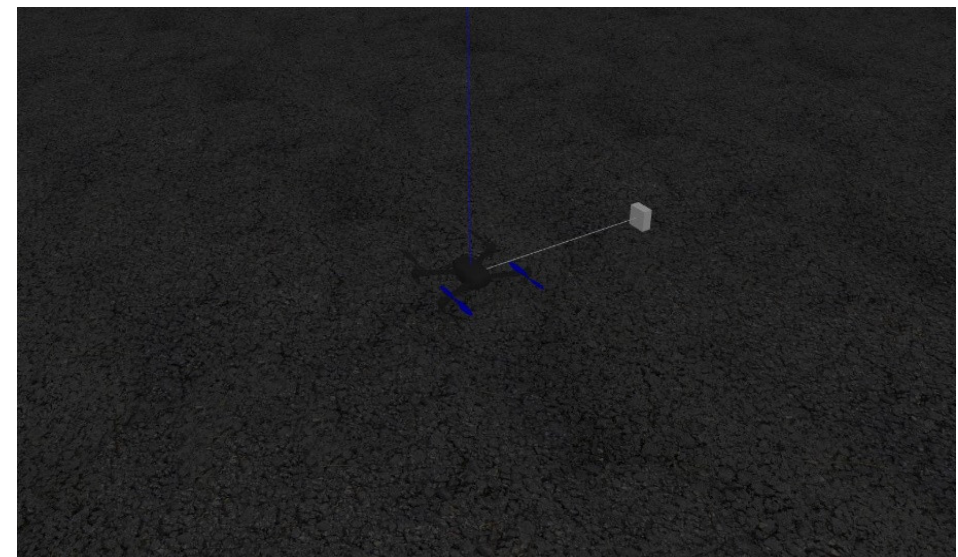
Figure 8 . Gazebo model hierarchy .